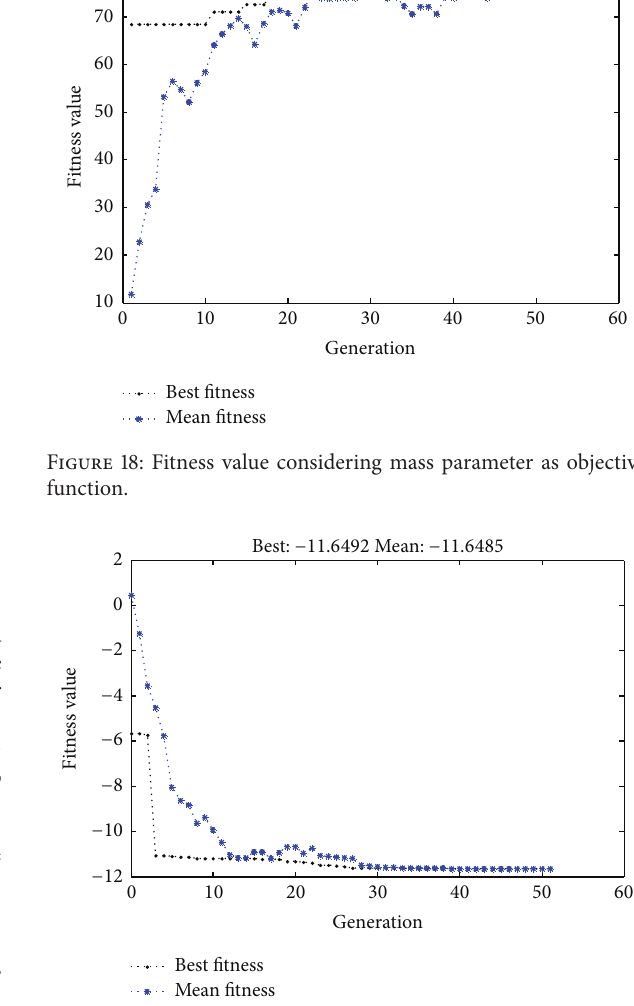
Figure 19: Fitness value combining all the objective